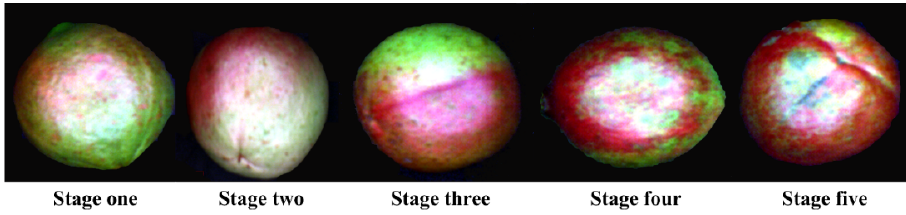
Figure 2. Pseudo-color images showing the five maturity stages of typical Camellia oleifera fruit samples.